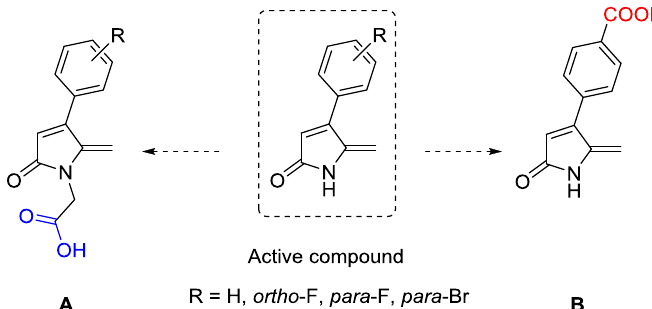
Figure 1. Functionalization of active dihydropyrrolones (DHP) with carboxylic acid group at N-1 position ( A ), and C-4 phenyl ring ( B ).